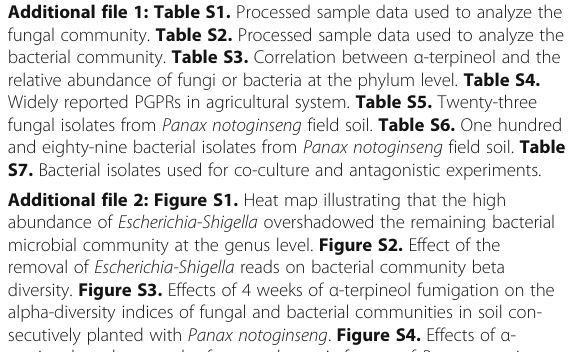
Additional file 1: Table S1. Processed sample data used to analyze the fungal community. Table S2. Processed sample data used to analyze the bacterial community. Table S3. Correlation between α -terpineol and the relative abundance of fungi or bacteria at the phylum level. Table S4. Widely reported PGPRs in agricultural system. Table S5. Twenty-three fungal isolates from Panax notoginseng field soil. Table S6. One hundred and eighty-nine bacterial isolates from Panax notoginseng field soil. Table S7. Bacterial isolates used for co-culture and antagonistic experiments. Additional file 2: Figure S1. Heat map illustrating that the high abundance of Escherichia-Shigella overshadowed the remaining bacterial microbial community at the genus level. Figure S2. Effect of the removal of Escherichia-Shigella reads on bacterial community beta diversity. Figure S3. Effects of 4 weeks of α -terpineol fumigation on the alpha-diversity indices of fungal and bacterial communities in soil